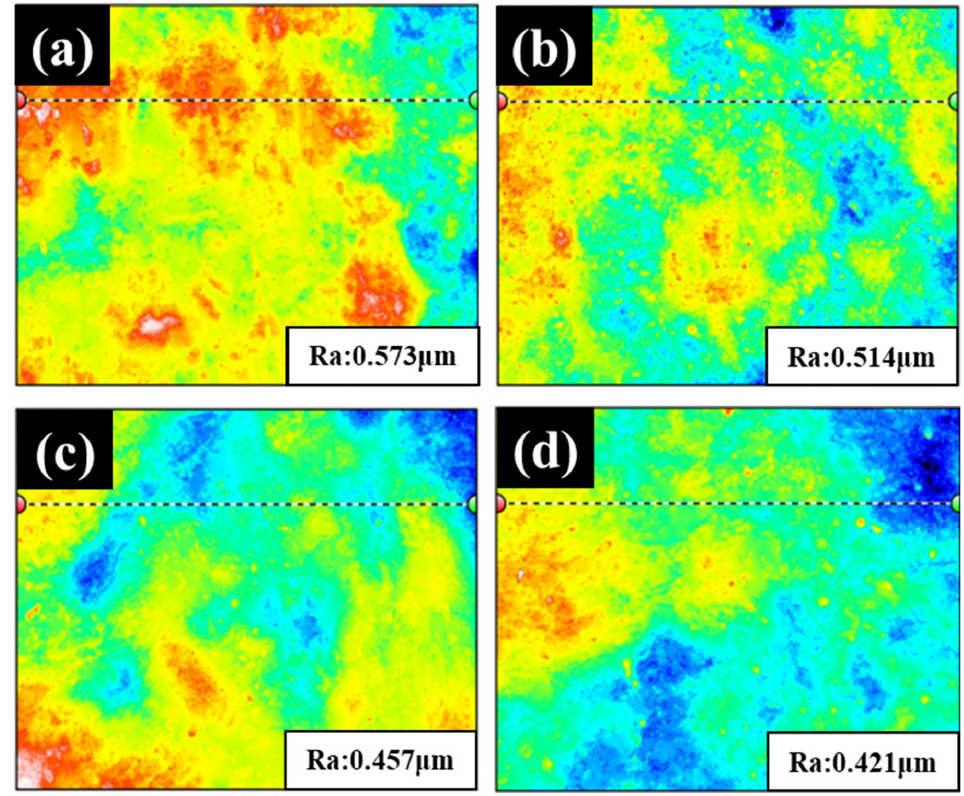
Figure 3. Three-dimensional white light diagram of LZ91 Mg alloy after acid pickling pretreatment for ( a ) 30 s, ( b ) 60 s, ( c ) 90 s, and ( d ) 120 s.